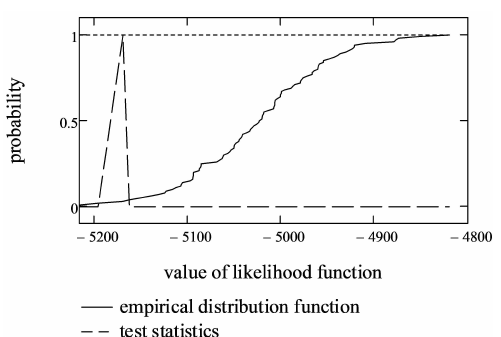
Figure 4. The empirical distribution function of LLF and test statistics of the stock market data.